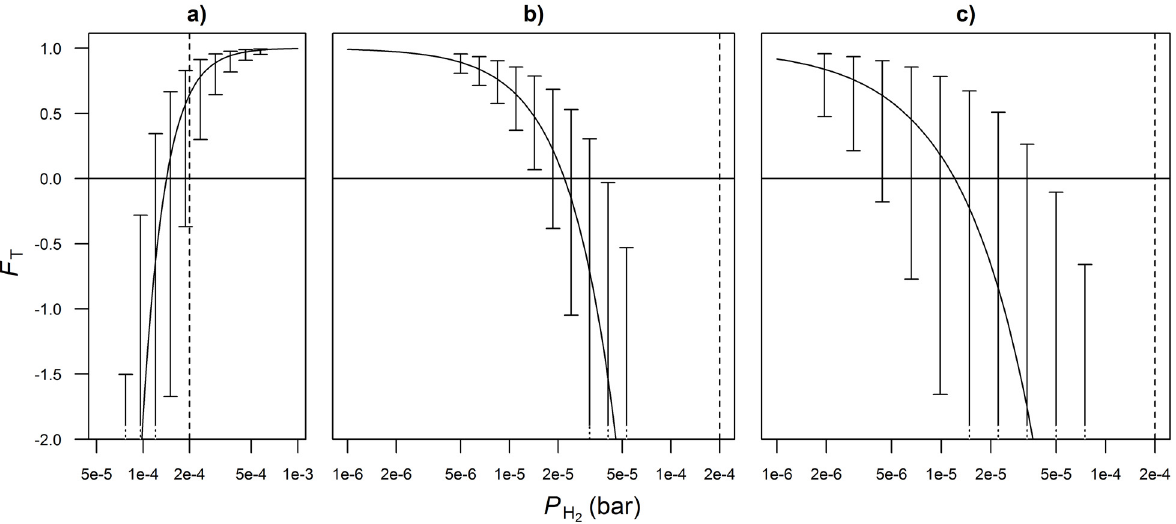
Fig 3. Thermodynamic potential factor ( F T ) as a function of P H propionate, b) propionate to acetate, c) butyrate to acetate. The 95% confidence intervals represent uncertainty of F T to variation in inputs . Vertical lines demarcate the rumen physiological lower bound of P H other than P H 2